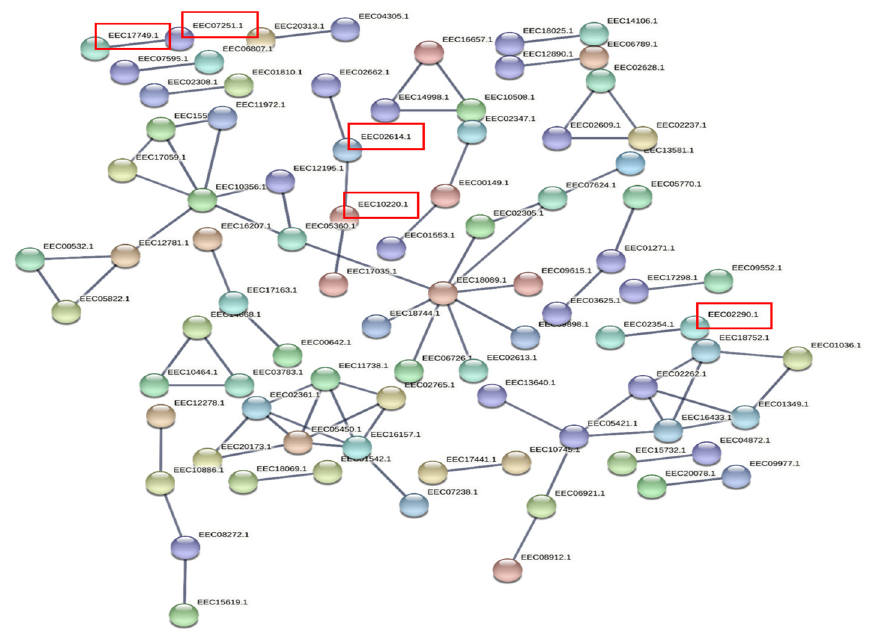
Figure 4. A network built exclusively from Ixodes scapularis proteins targeted by in silico differentially expressed miRNAs in Borrelia-burgdorferi -infected, partially fed salivary glands relative to partially fed clean salivary glands. Red boxes indicates the proteins involved in significant KEGG pathways such as sphingolipid metabolism (EEC07251.1, KEGG:R02541); valine, leucine, and isoleucine degradation (EEC10220.1, KEGG:R04188); lipid transport and metabolism (EEC02614.1, KEGG:R01178); exo- some biogenesis and secretion (EEC07251.1, EEC17749.1, KEGG:R02541); and phosphate-containing compound metabolic process (EEC02290.1,